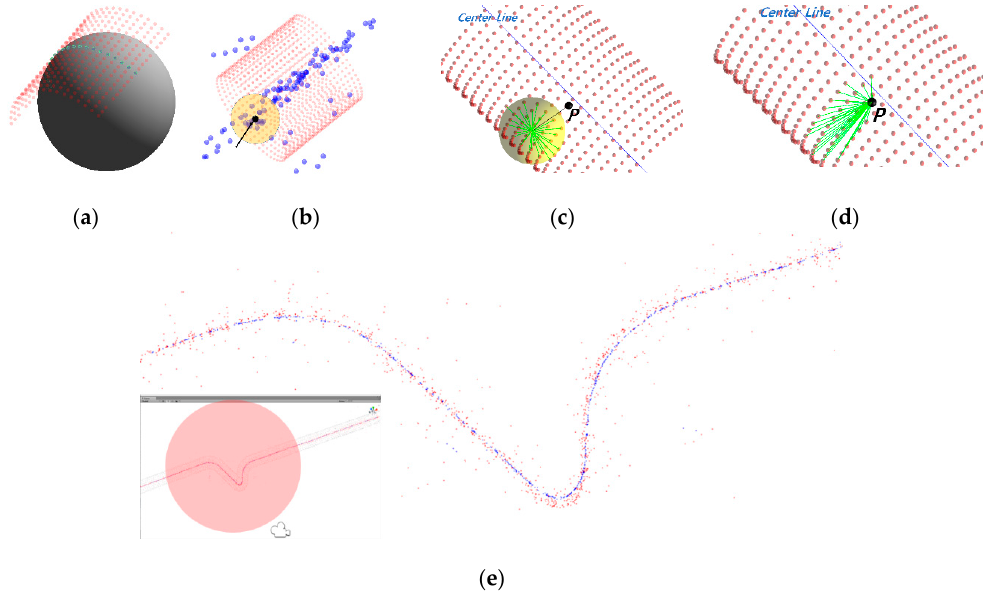
Figure 4. ( a ) Neighboring points and fitting results for spherical fitting. ( b ) Outlier removal through local averaging. ( c ) Sphere fitting using six points in cross-section. ( d ) Neighboring point search. ( e ) Average filter processing result. ( e ) Average filter processing